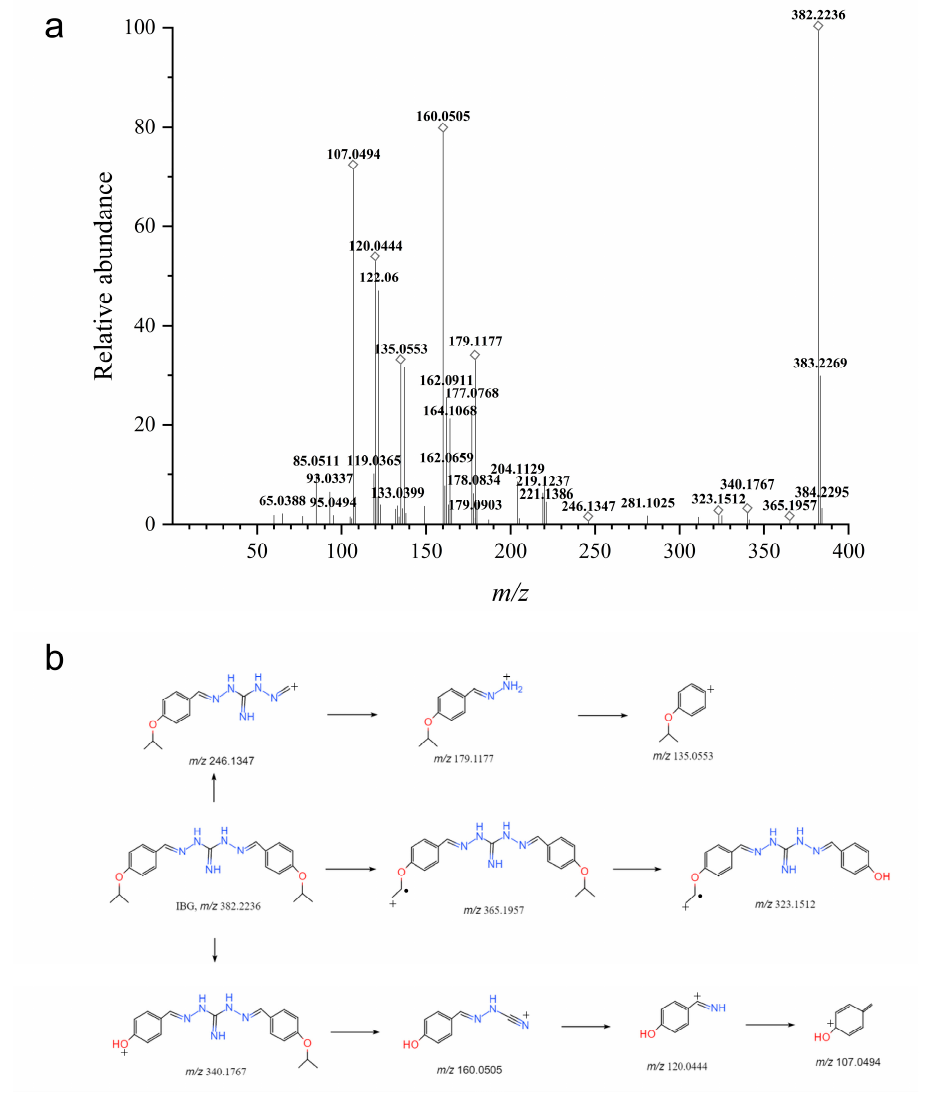
Figure 2. Collision-induced dissociation spectrum of IBG ( a ) and proposed fragmentations ( b ).